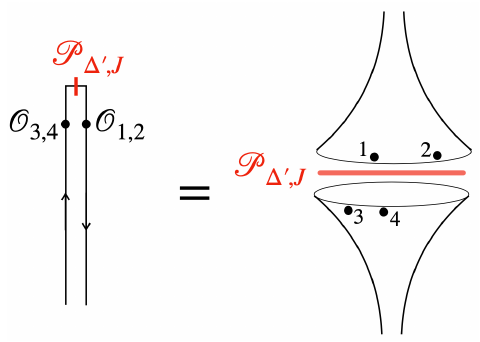
Figure 14 . A resolution of identity for four-point functions. To prove the positivity, it is convenient to place O 1 , 2 and O 3 , 4 on different parts of the in-in contour so that the four-point function can be interpreted as an overlap of two states, shown on the right hand side of the